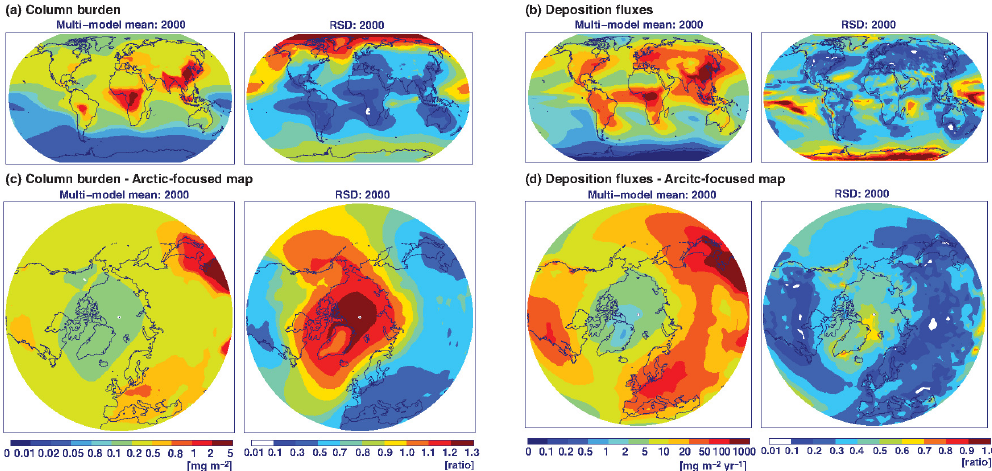
Fig. 3. Global distributions of the multi-model mean and RSD (relative standard deviation) of (a) BC column burden and (b) total BC deposition fluxes in 2000. (c) and (d) are the same as (a) and (b) , respectively, but with Arctic-focused maps (latitude: 30 ◦ N to 90 ◦ N).